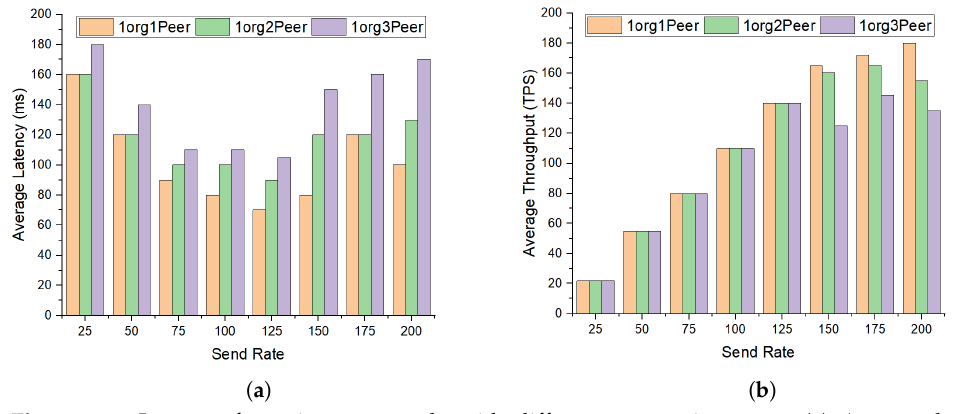
Figure 16. Impact of varying peer node with different transaction rate. ( a ) Average latency; ( b ) average